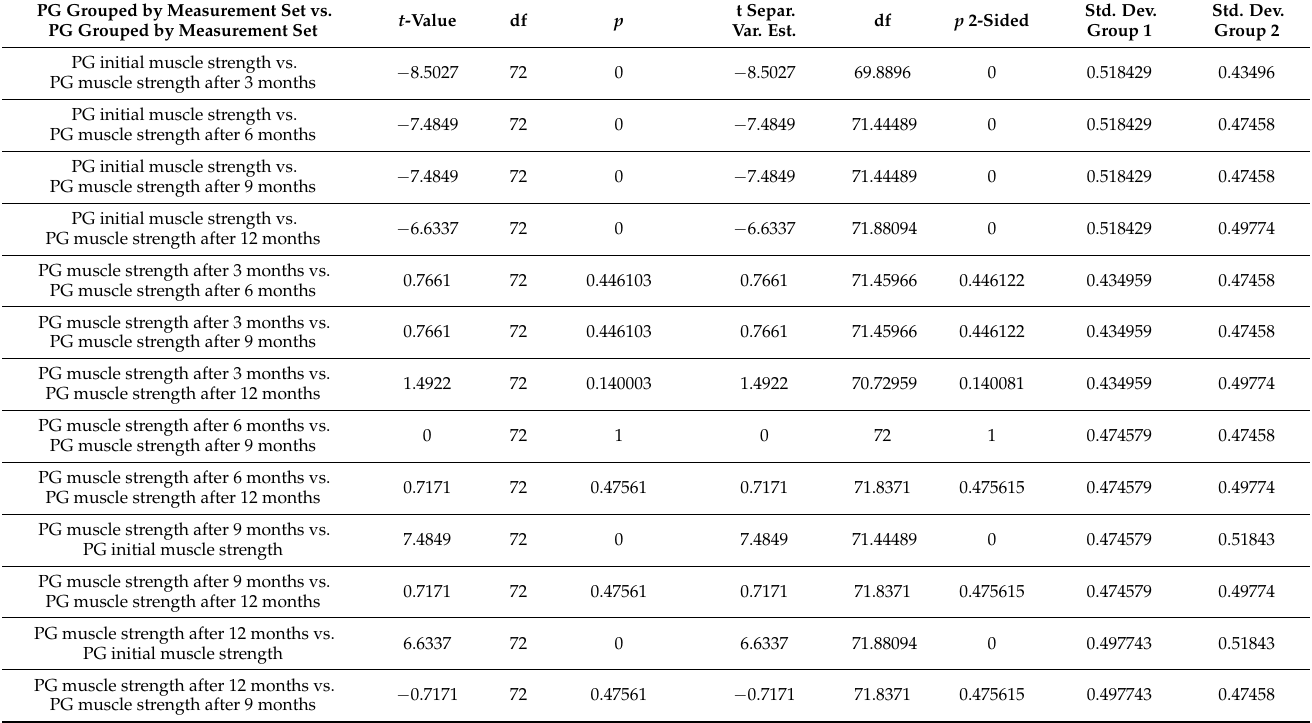
Table 7. t -test between CG muscle strength measurement sets of the